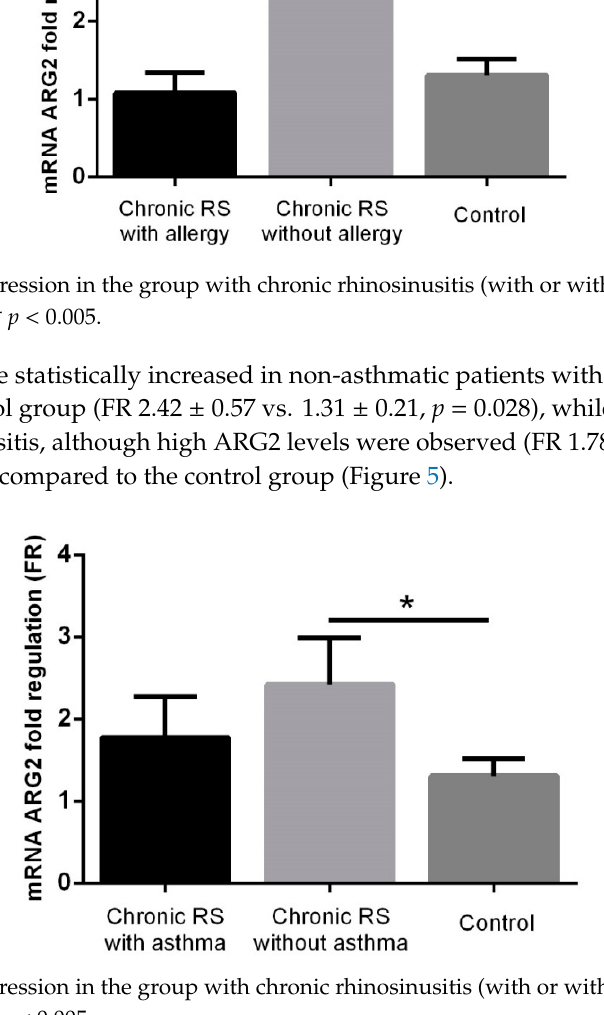
Figure 3. ARG2 expression in the group with chronic rhinosinusitis (RS) (with or without polyps) and in the control group. * p < 0.05.